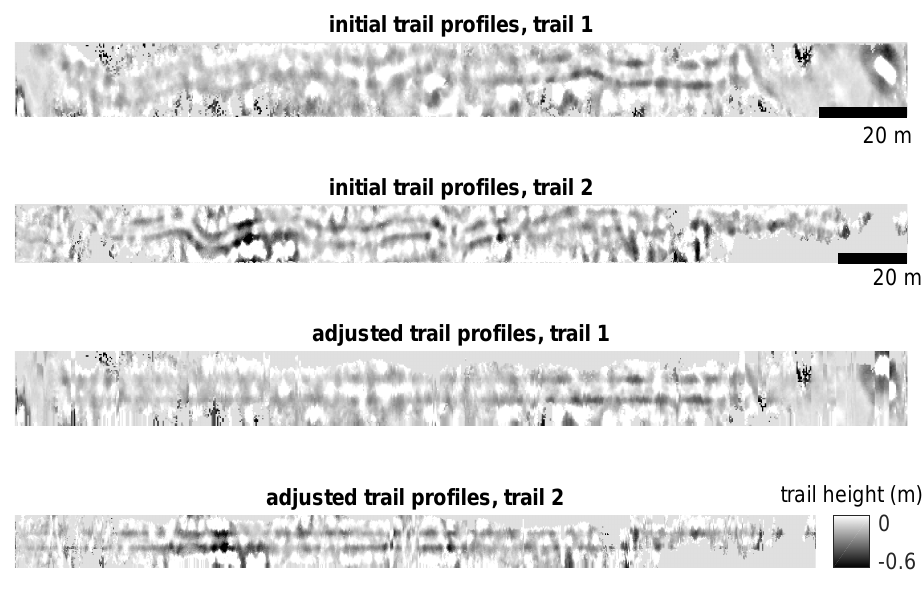
Figure A5. Top two: Trail profiles in the u direction after the trail center line has been fixed with the height convolution adaptation. Bottom: Trail profiles in the u direction after the local profile adjustment. Note: the height scale given concerns all height plots.